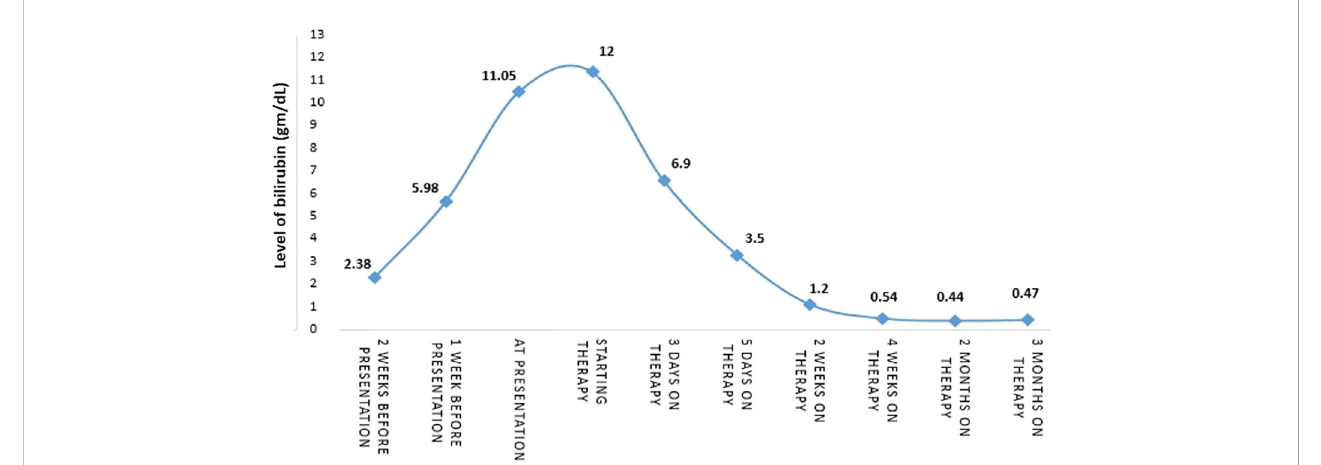
FIGURE 3 The patient ’ s timeline for cancer treatment and bilirubin levels.